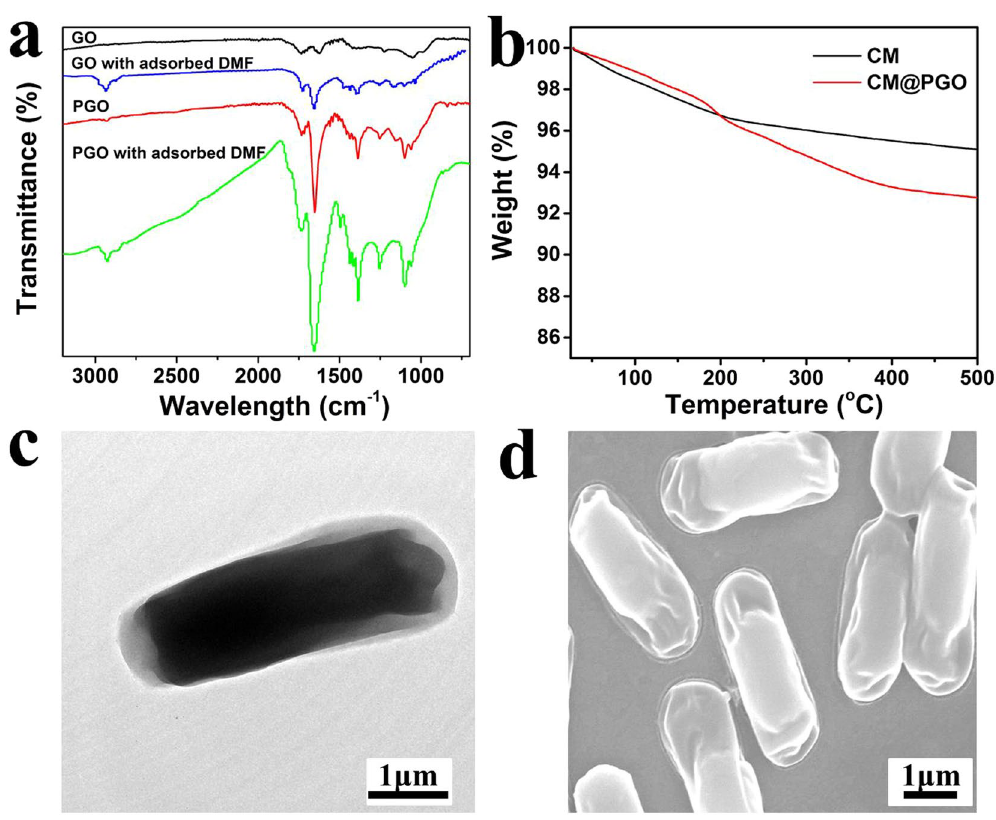
Figure 5. The Infrared Spectroscopy of GO, PGO and the GO, PGO with adsorbed DMF ( a ) and TGA curves of CM and CM@PGO obtained in N 2 atmosphere with the rate of 10 °C/min ( b ) and the TEM ( c ) and SEM ( d ) images of P . denitrificans